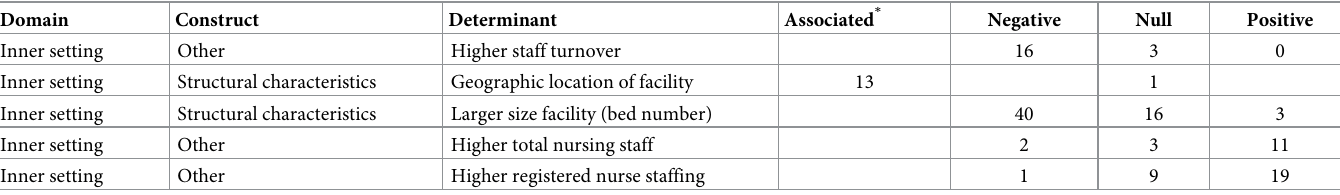
Table 7. Determinants of regulatory compliance where evidence is most